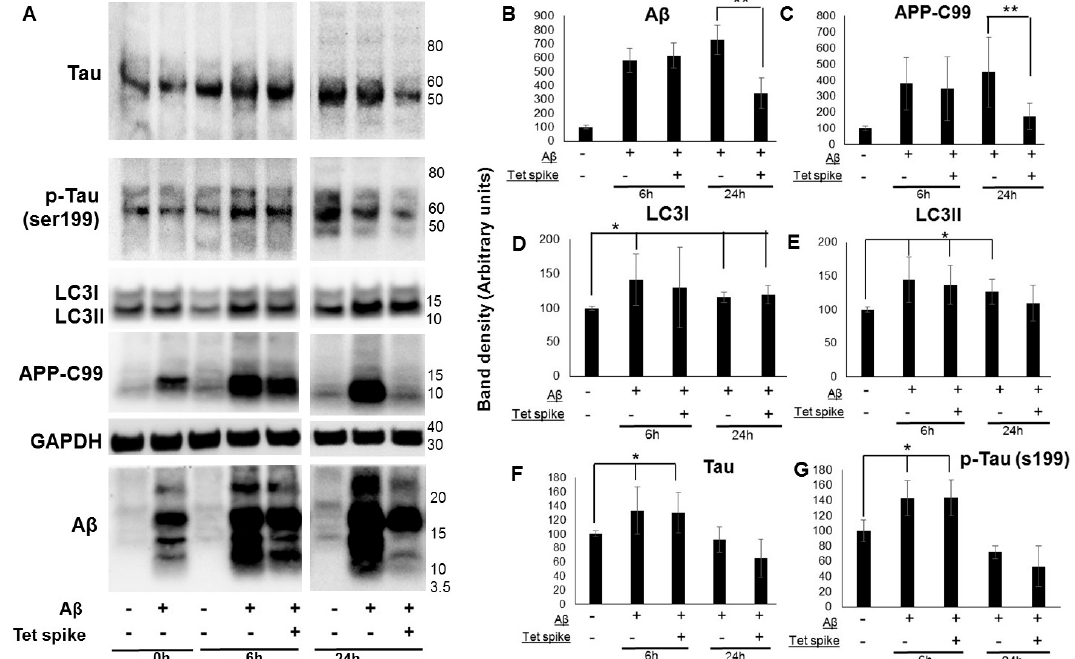
Figure 2. Clearance of APP-C99 and A β in an AD neuronal cell model. Clearance of APP-C99 and A β was assessed in MC65, a human derived cell line that produces A β from a stably transfected precursor protein APP fragment C99. MC65 cells were grown without tetracycline for two days to activate APP-C99 and A β production, followed by spiking with tetracycline to block APP-C99/A β production. After spiking with tetracycline (1 µg/mL), cell lysates were collected at 6 and 24 h to measure levels of A β ( B ), APP-C99 ( C ), LC3I ( D ) LC3II ( E ), Tau protein ( F ), and phosphorylated Tau protein (ser199) ( G ) by western immunoblotting analysis. Representative image of the A β clearance assay is shown here ( A ). APP-C99 and A β levels were ~50% lower at 24 h in cells spiked with tetracycline compared to tetracycline depleted cells (** p < 0.001, n = 4), suggesting clearance. A β producing MC65 cells (tetracycline depleted) showed increased accumulation of Tau protein, phosphorylated Tau protein (ser199) at 6 h and autophagy markers LC3I and LC3II (* p < 0.005, n = 4) at both 6 and 24 h, suggesting increased autophagosome synthesis and autophagy activation.